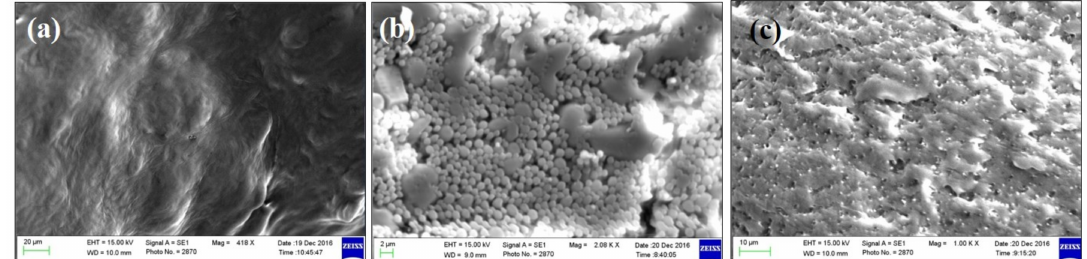
Figure 3. SEM micrographs of ( a ) phospholipid, ( b ) green tea extract and ( c ) green tea extract-loaded phytosome (batch